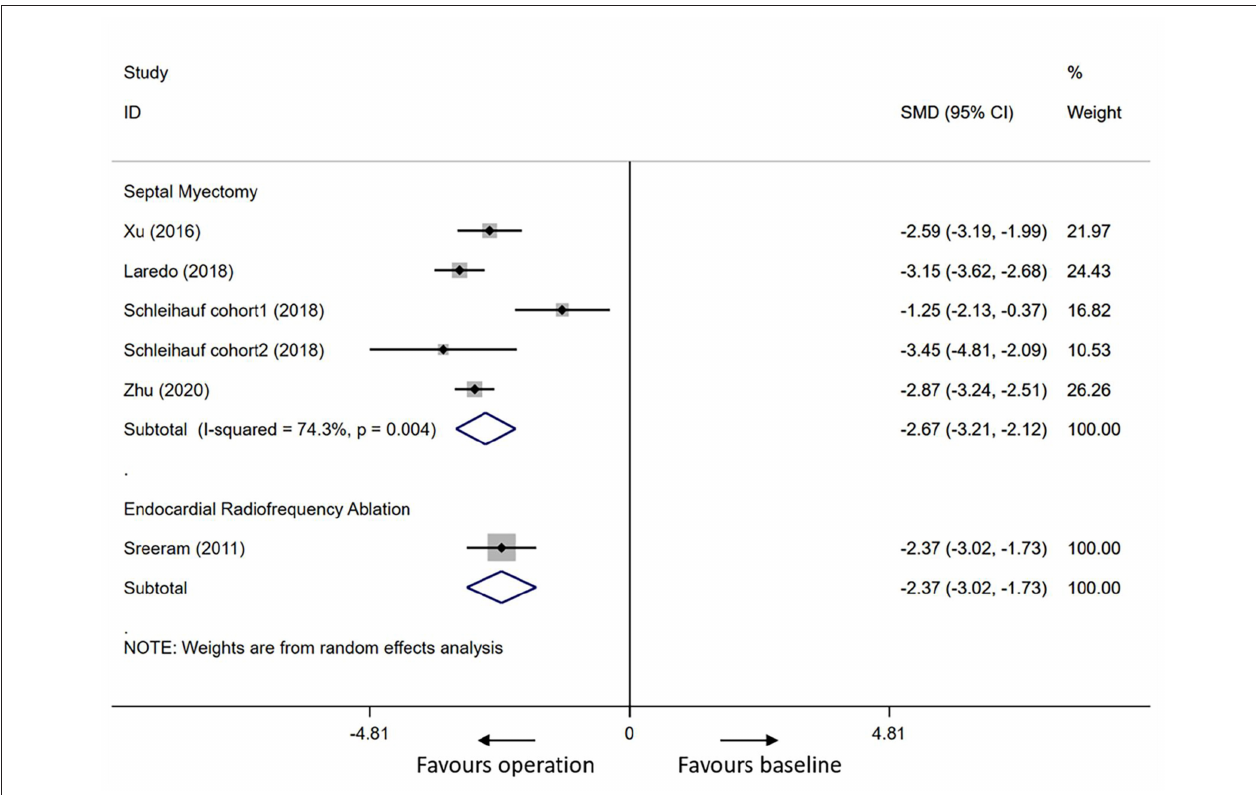
FIGURE 3 | Forest plot for the resting LVOTG in children after septal myectomy or endocardial radiofrequency ablation. LVOTG, left ventricular outflow tract gradient.